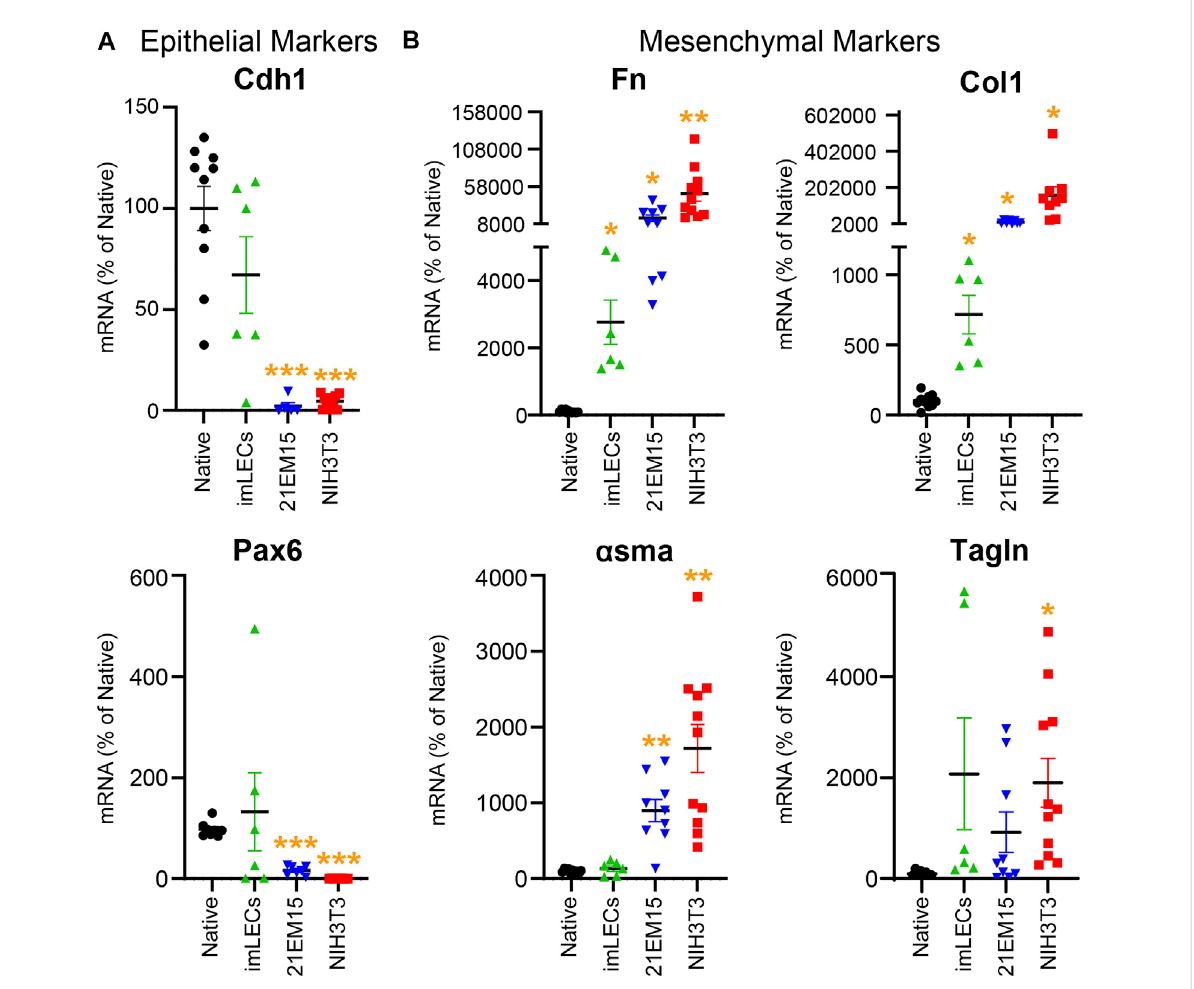
FIGURE 5 Analysis comparing the mRNA levels isolated from native mouse lens epithelial cells (Native), mouse immortalized lens epithelial cells (imLECs and 21EM15), and mouse fi broblasts (NIH3T3). (A) mRNA levels for the lens epithelial cell marker genes cadherin-1 (Cdh1) and paired box 6 (Pax6). WhiletheimLECcelllinehadnosigni fi cantdifferenceintheexpressionforepithelialcellmarkerscomparedtonativecells, 21EM15andNIH3T3 cells had signi fi cantly lower expression of epithelial cells markers than native lens epithelial cells. (B) mRNA levels for the mesenchymal/ fi broblastic marker genes fi bronectin (Fn), collagen-1 (Col1), α -smooth muscle actin ( α sma), and transgelin (Tagln). The imLEC cell line had elevated expression forFnandCol1whencomparedtothatofnativelensepithelialcells.Boththe21EM15andNIH3T3celllineshadgreatermesenchymalcharacteristics with substantially reduced epithelial marker mRNA levels and highly elevated mesenchymal/ fi broblast marker mRNA levels. Dot plots show the average and standard error of mean. Individual genes were normalized to 18S. The mRNA levels were calculated using delta – delta Ct method and expressed as a percentage of native lens epithelial cell controls. *, p < 0.05; **, p < 0.01; ***, p <